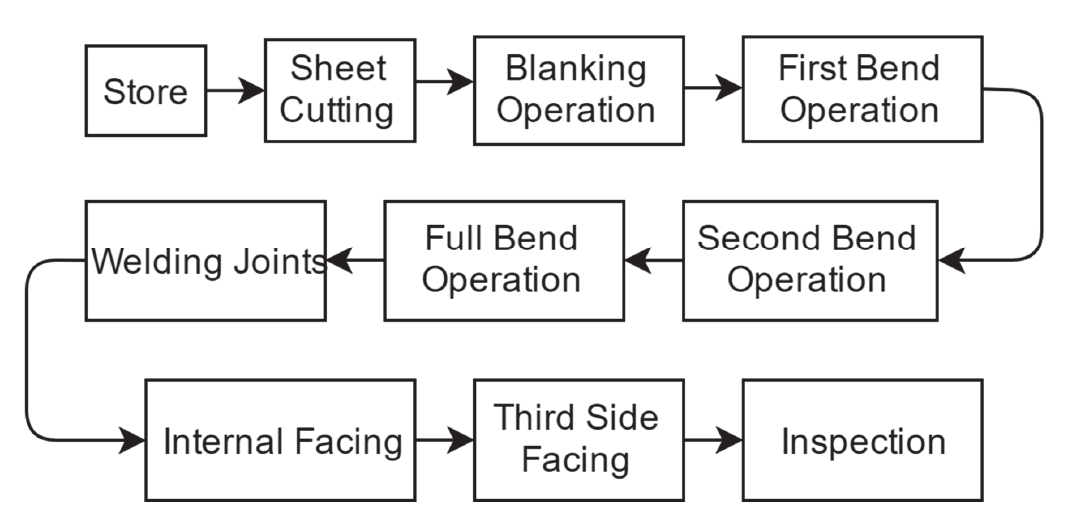
Fig. 1. Process flow chart of the frame